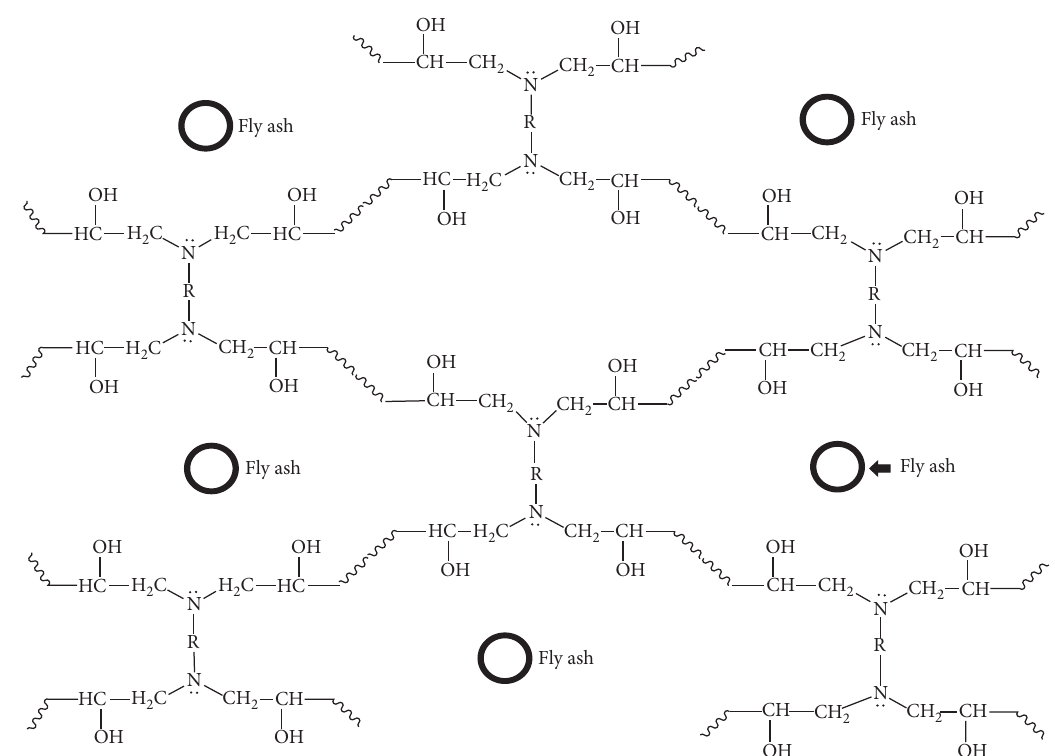
Figure 1: Images of fly ash particles alternating between epoxy molecules after plastic curing [15]. Table 1: Specification of epoxy Epikote 240 resin. Property